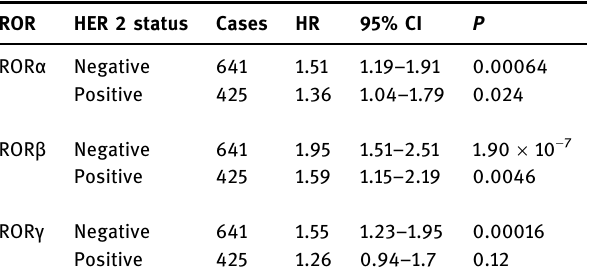
Table 2: Correlation of RORs mRNA expression with HER 2 status of patients with GC ROR HER 2 status